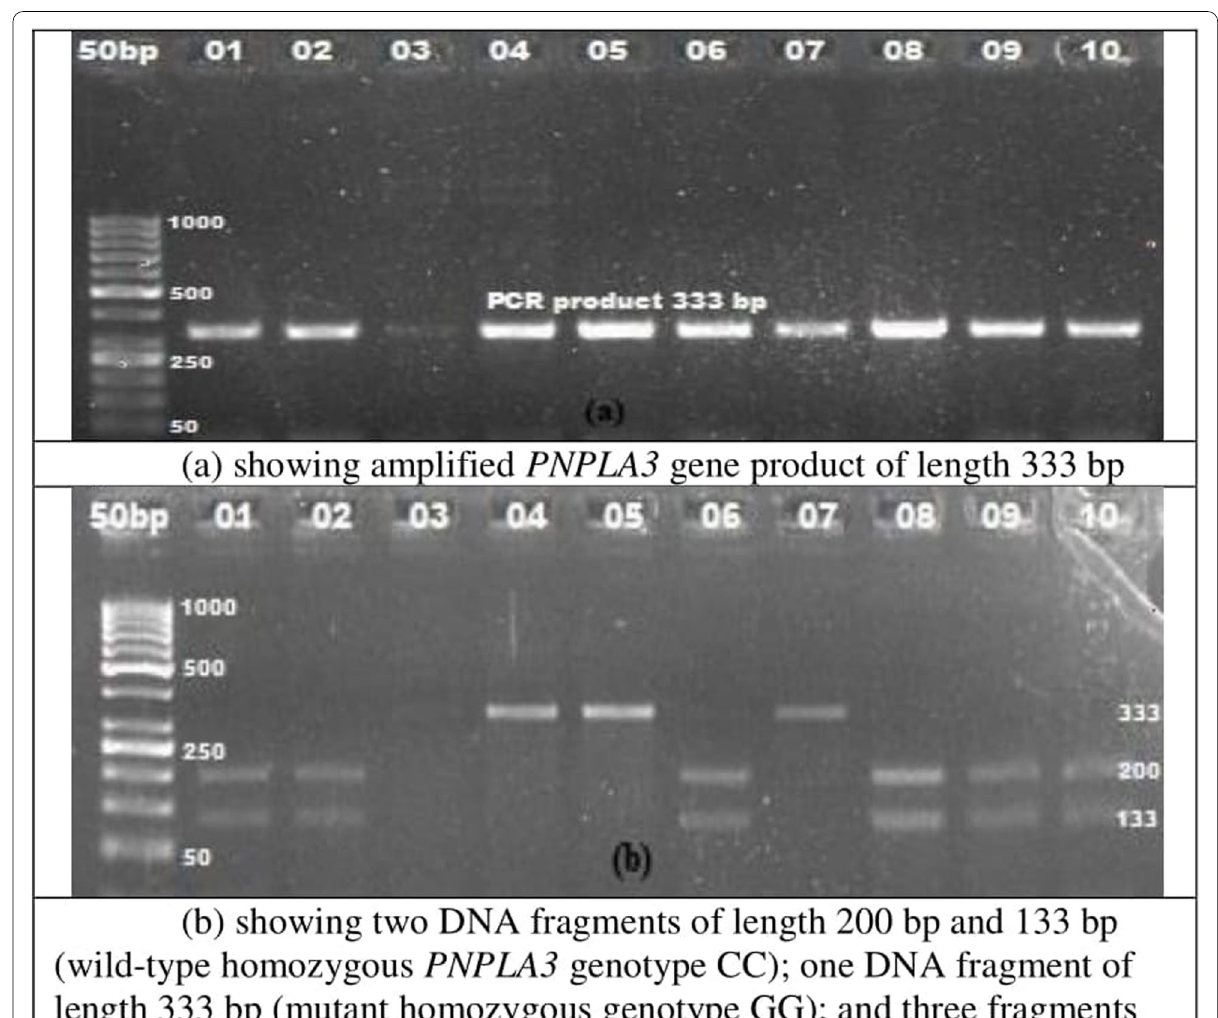
Fig. 1 PCR-RFLP results of PNPLA3 rs738409